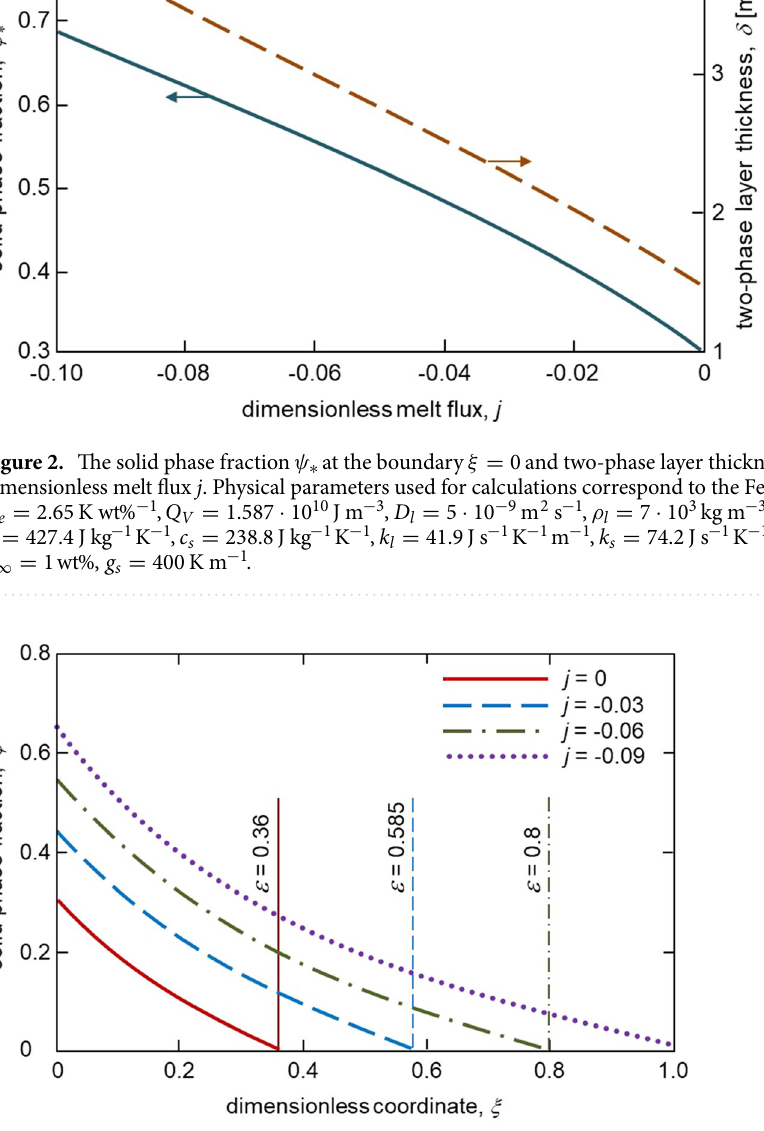
Figure 3. The solid phase fraction ψ as a function of spatial coordinate ξ in the two-phase layer for various melt fluxes j . Vertical lines show dimensionless thicknesses of the two-phase layer for various j